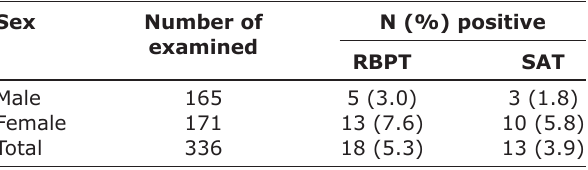
Table-1: Seroprevalence of bovine brucellosis in Bauchi State, Nigeria based on sex distribution. Sex